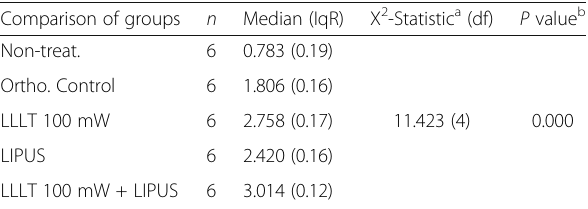
Table 3 Comparison of median of RANKL gene expression levels among the study groups at day 21 Comparison of groups Non-treat.